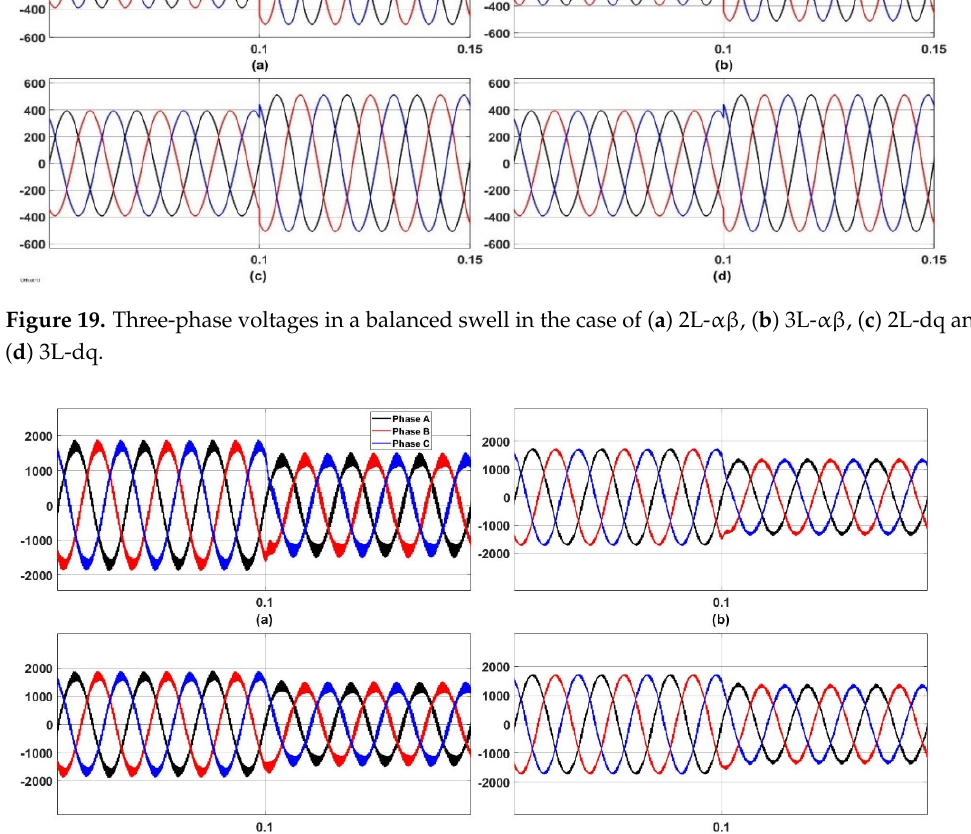
Table 5. Case 3 results.